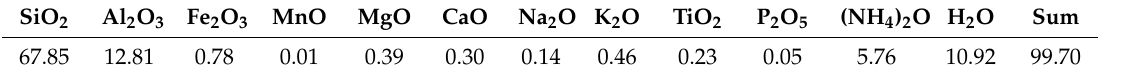
Table 2. Chemical composition of sample ES-NH (values in wt %).